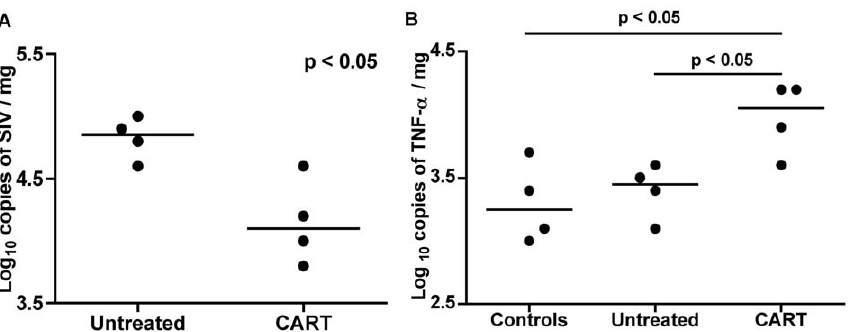
Figure 6. Quantification of virus burden and expression of TNF- a in myocardial tissue by real time RT-PCR. Tissue virus burdens were significantly lower in the left ventricles of animals that received CART as compared to untreated controls ( A ). Horizontal bars represent median values for each data set. Real-time RT-PCR with TNF- a specific TaqMan probe revealed significantly greater levels of TNF- a expression in the myocardium of animals that received CART as compared to control animals ( B ). Note that TNF- a expression in the untreated group is similar to SIV-negative controls. Horizontal bars represent median values for each data set.